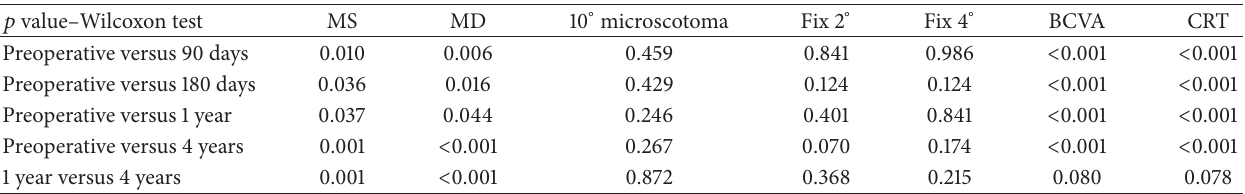
Table 3: Statistical analysis (MS: mean sensitivity; MD: mean defect; Fix: fixation; BCVA: best-corrected visual acuity; CRT: central retinal